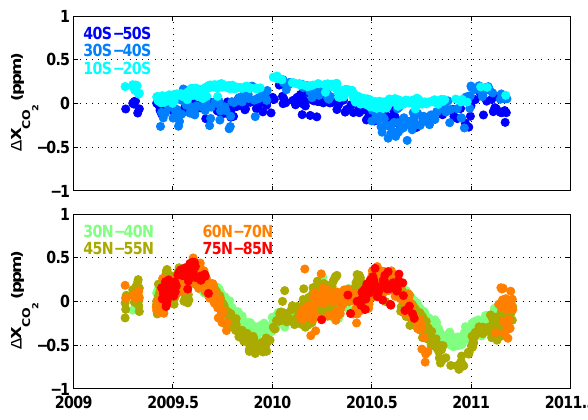
Fig. 12. The latitude-dependence of the difference between us- ing the TCCON a priori profile and the ACOS a priori profile (TCCON − ACOS plotted here) on the ACOS-GOSAT retrievals − ˆ c (e.g., ˆ c 0 1 from Eq. A10). The latitudes are binned around TC- 1 CON